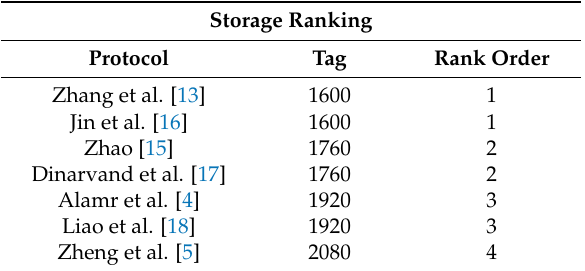
Table 10. Ranking based on tag storage of required protocol parameters.